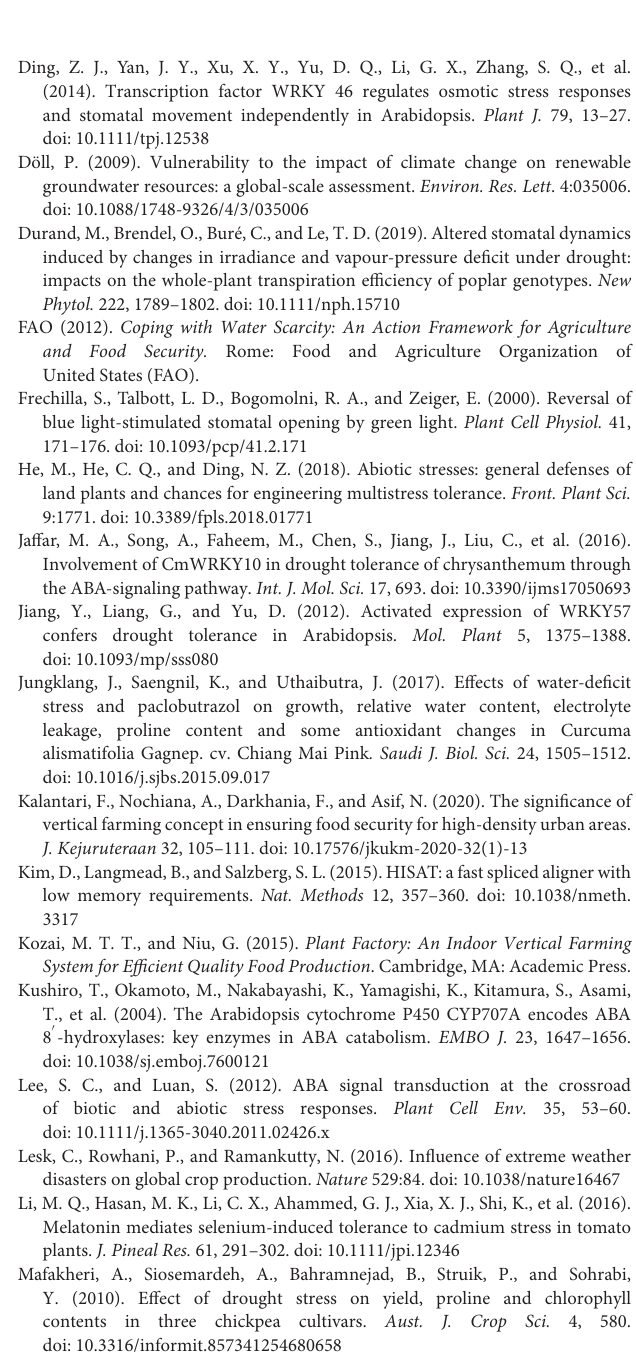
Supplementary Figure 2 | The expression patterns of 10 randomly selected DEGs by RNA-Seq and qPCR. Gene expression is shown in a heatmap with color scale representing log 2 (fold change) (blue: low expression level; red: high expression level). A scale indicating the color assigned to log 2 (fold change) is shown to the right of the heatmaps.